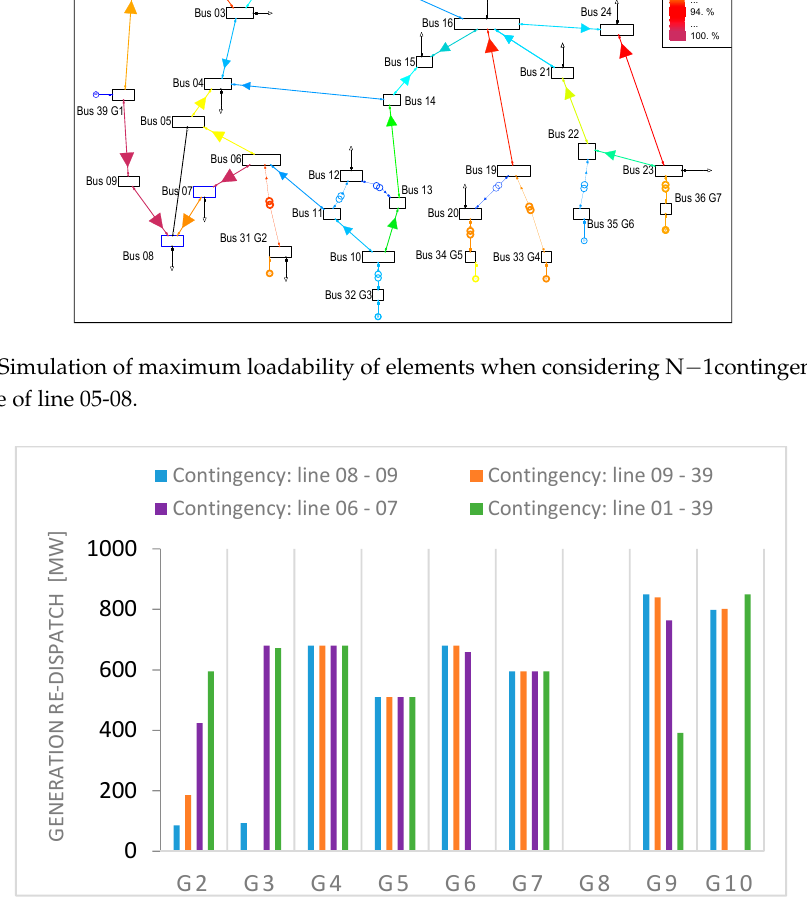
Figure 8. Emergency dispatch after a contingency that considers the outage of line 05–08.